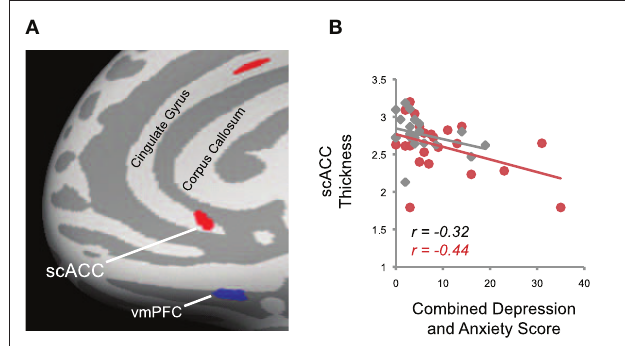
FIGURE 7 | Relationship between depression and anxiety and cortical thickness. (A) Right subcallosal anterior cingulate cortex (scACC) and dorsal anterior cingulate cortex exhibited a negative relationship between combined depression and anxiety scores and cortical thickness (red). The mirrored location of reduced gray matter volume in tinnitus patients in left vmPFC ( Figure 3A , top panel) is also displayed for reference (blue), illustrating the spatial dissociation of the two effects. The inflated surface was rotated from the medial aspect of the brain along the y-axis so that all clusters are within view. (B) Data from the scACC cluster shown in (A) is plotted for each tinnitus patient (red) and control (gray). Regression lines and Pearson’s r values for each group are displayed, which show the negative relationship between depression/anxiety scores and cortical morphology in this